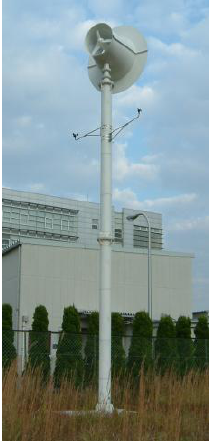
Figure 7. 500 W wind-lens turbine (rotor diameter 0.7